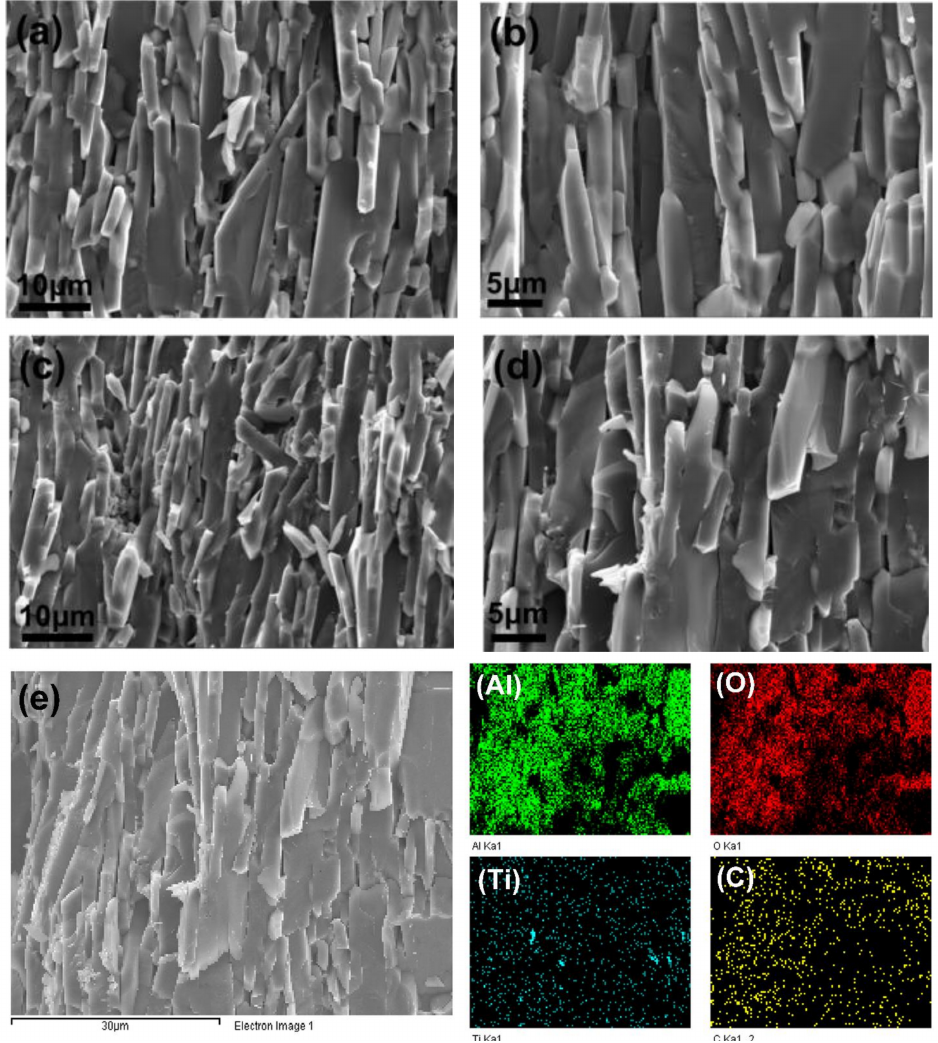
Figure 6. SEM images of fracture surface, ( a , b ) A4; ( c , d ) A5 and ( e ) ESD analysis of